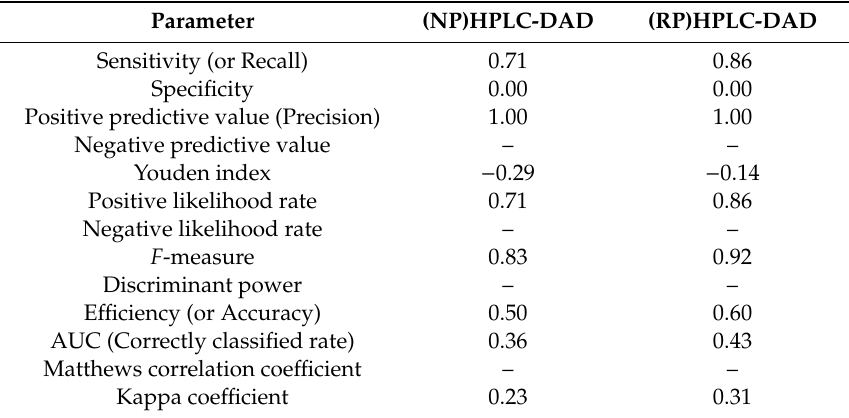
Table 5. Quality metrics of the SIMCA